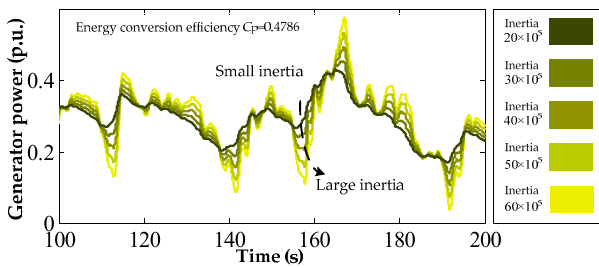
Figure 4. Power fluctuations with different turbine inertia under the same conversion efficiency.